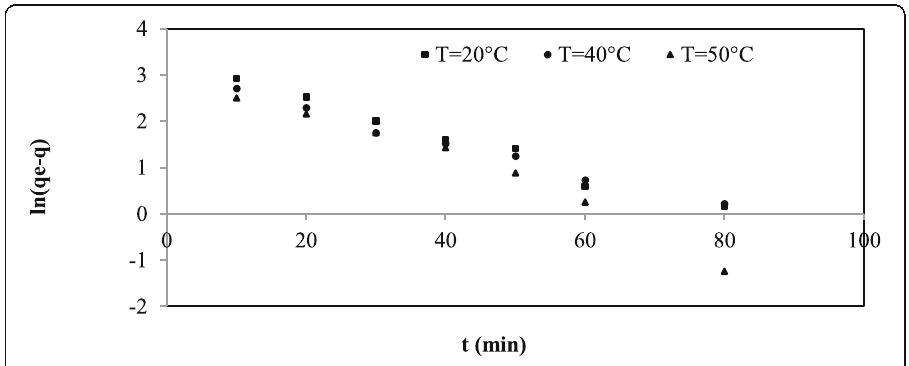
Fig. 15 Pseudo-first-order